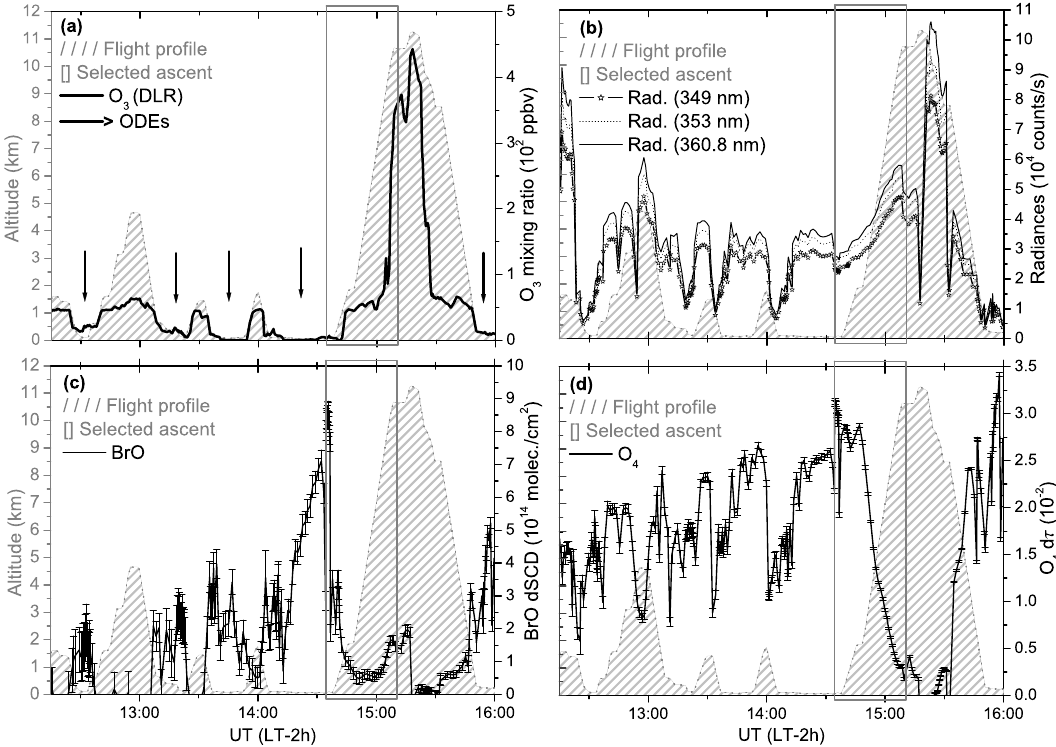
Fig. 1. Measurement flight on 8 April 2007 (72–80 ◦ SZA). Panel (a) shows the O 3 mixing ratios measured in situ with an UV absorption photometer (DLR). Flight sections within the Arctic BL with ODEs are indicated by arrows. Panels (b) – (d) show, resp., the radiances at different wavelengths, the BrO dSCDs and the O 4 dτ measured with the UV channel of the mini-DOAS instrument. The tropospheric vertical profiles of the aerosols E M and of the trace gases presented in this work are retrieved from data measured during the aircraft ascent starting at around 14:30UT